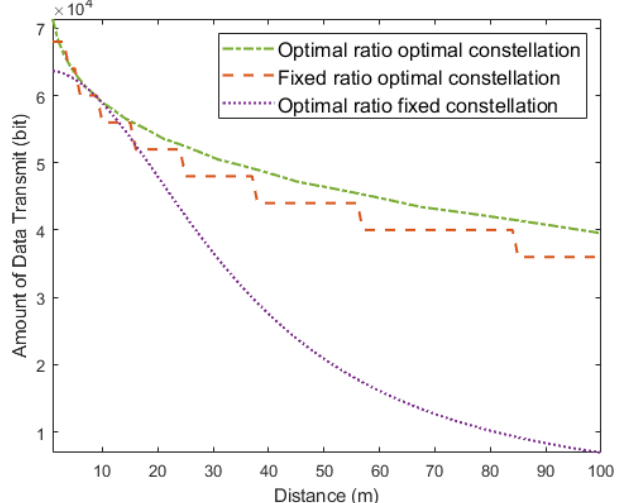
Figure 5. Fixed time ratio versus optimized time ratio at a fixed constellation.